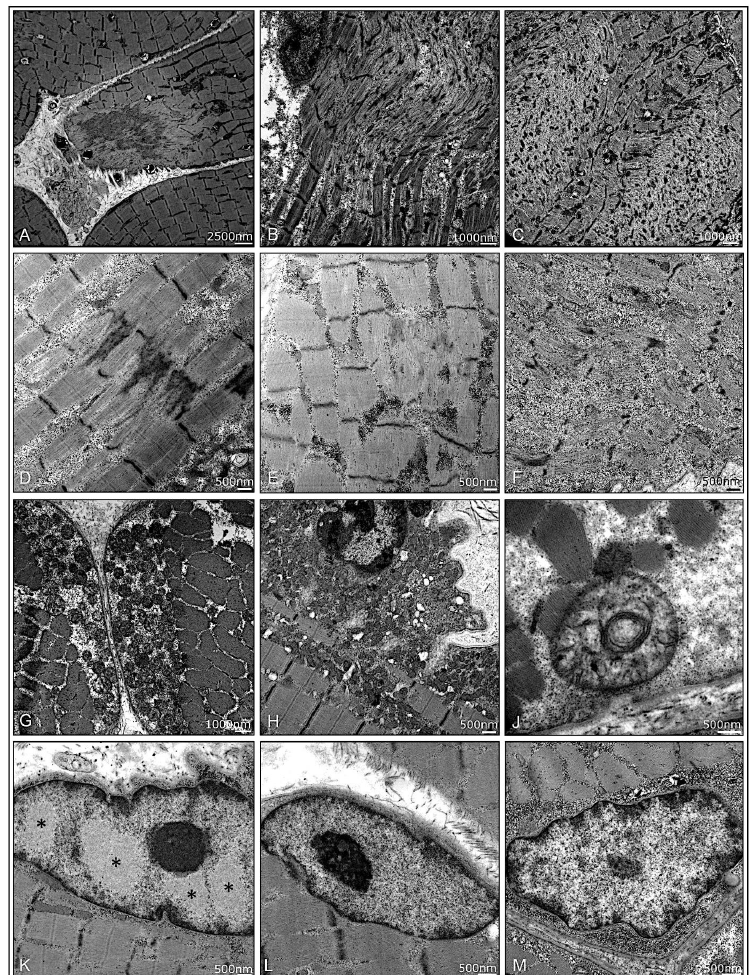
Figure 6. Ultrastructural pathology in muscle biopsies from patients with jIIM. A high variability of disruption of myofibrillar architecture can be present in all subtypes. Focal, core-like alterations of the sarcomeric architecture in DM (P10) ( A ), P4 ( B ), and P12 ( C ). Z-band alterations with Z-band stream- ing in P15 ( D ) and dissolving Z-bands in anti-Jo1-ASyS (P14) ( E ) and focal glycogen deposits in OM (P7) ( F ). Moderate mitochondrial pathology with some mitochondrial subsarcolemmal aggregation in PL-7-ASyS (P9) ( G ) and DM (P2) ( H ). Few mitochondria with increased variability of diameter and altered cristae structure in P9 ( J ). Myonuclei with characteristic filamentous nuclear inclusions were only found in anti-Jo1-ASys (P14); note the different patterns of euchromatin, heterochromatin, and the nucleolus, as compared to the nuclear inclusions (*) ( K ). No inclusions were found in PL-7-ASyS (P6, P9) ( L , M ). (DM = dermatomyositis; ASyS = antisynthetase syndrome; OM = overlap